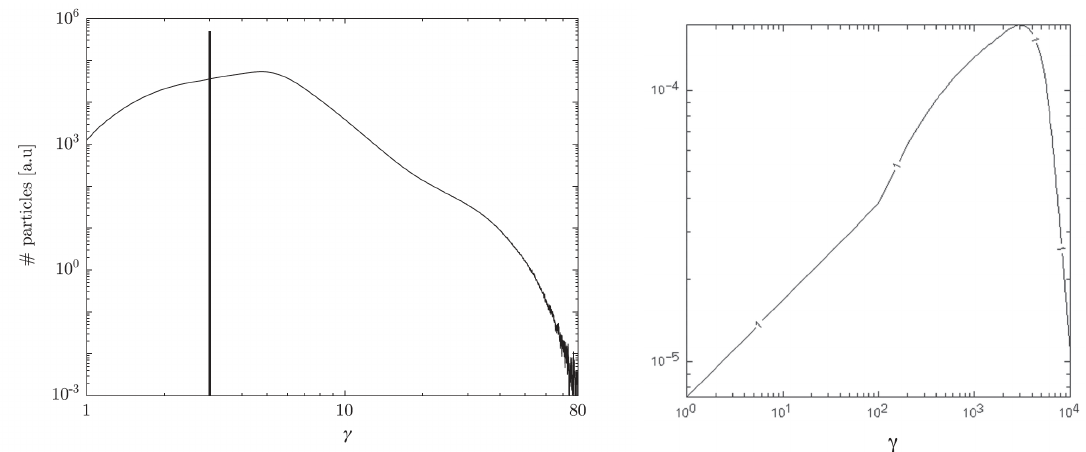
∼ γ 4 (cid:39) 80. From Ref. [62]. 0